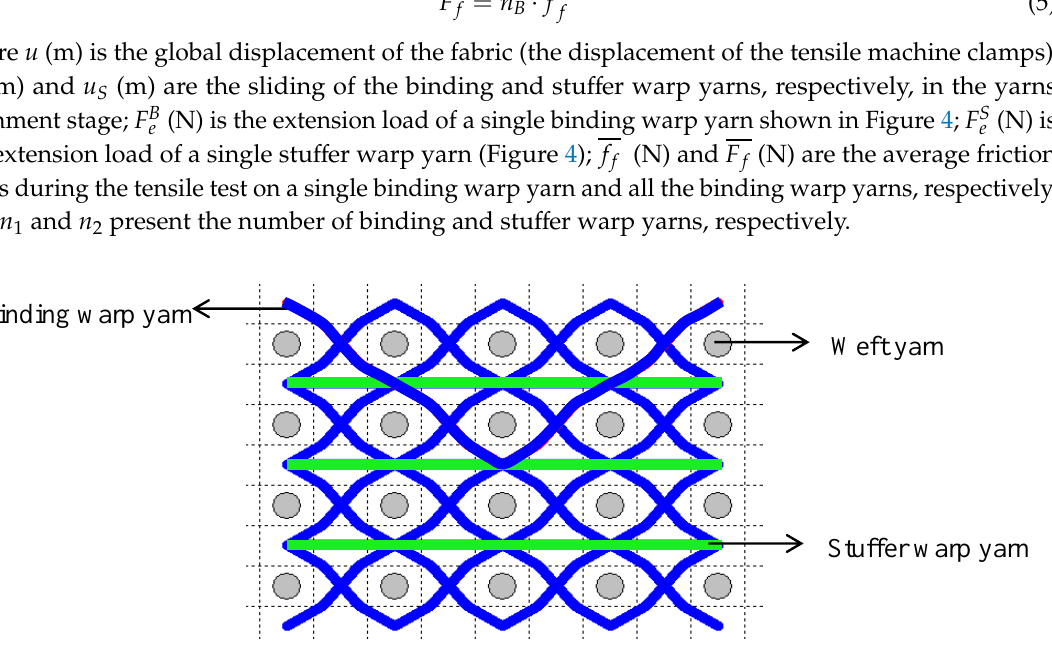
Figure 8. Average friction load–deformation of the binding warp yarns during the tensile tests of five different 3DWIFs samples. 3.5. Geometrical Model and the Crimp Angle 050100 150